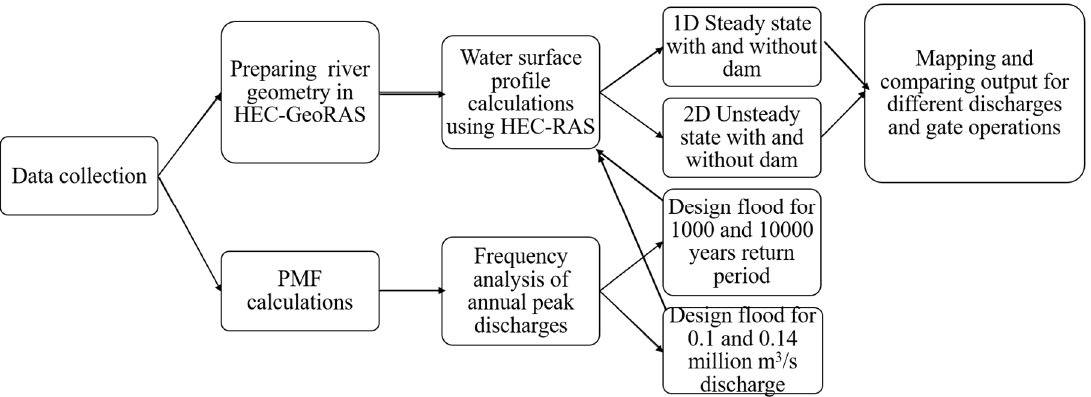
Figure 2. Flow chart of the methodology.